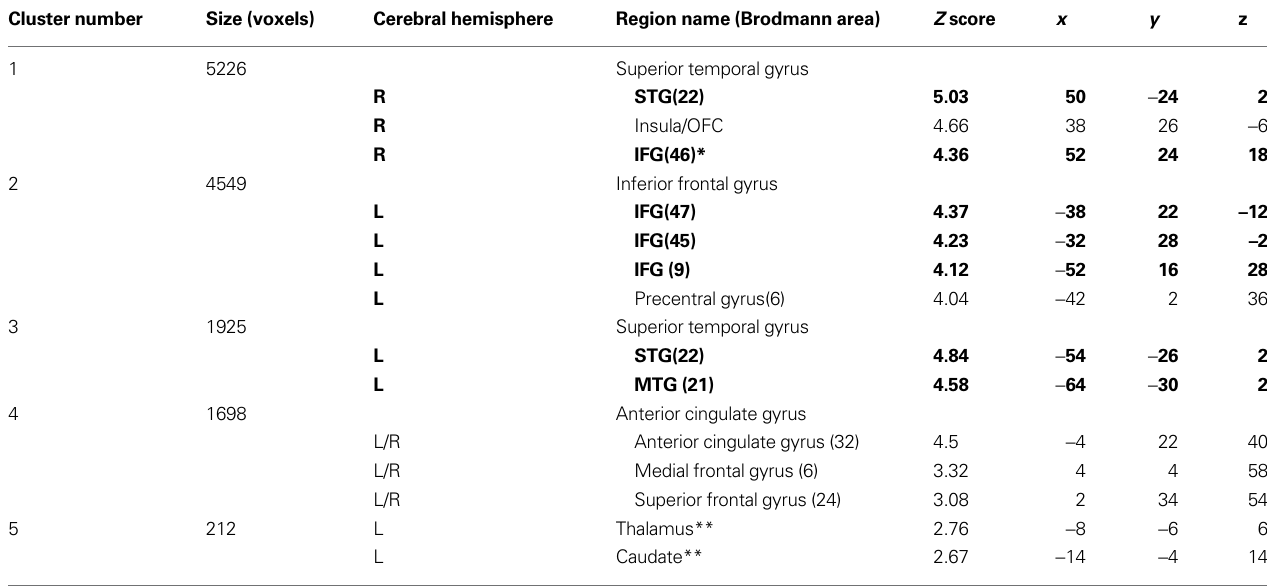
Table 2 | Mean cluster location and local maxima of BOLD signal change for all emotions > neutral. Cluster number Size (voxels) Cerebral hemisphere